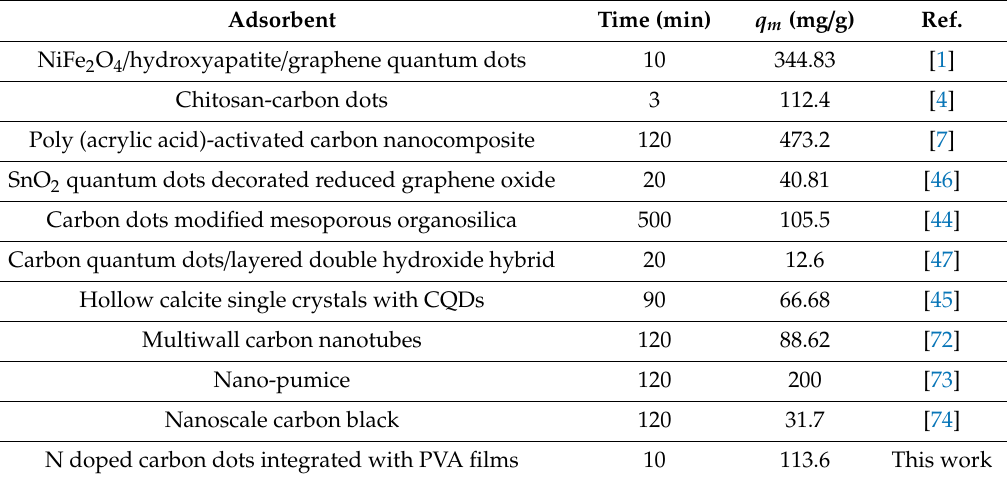
Table 2. Comparison of several nanoadsorbents used for Cd 2 + removal. Adsorbent Time